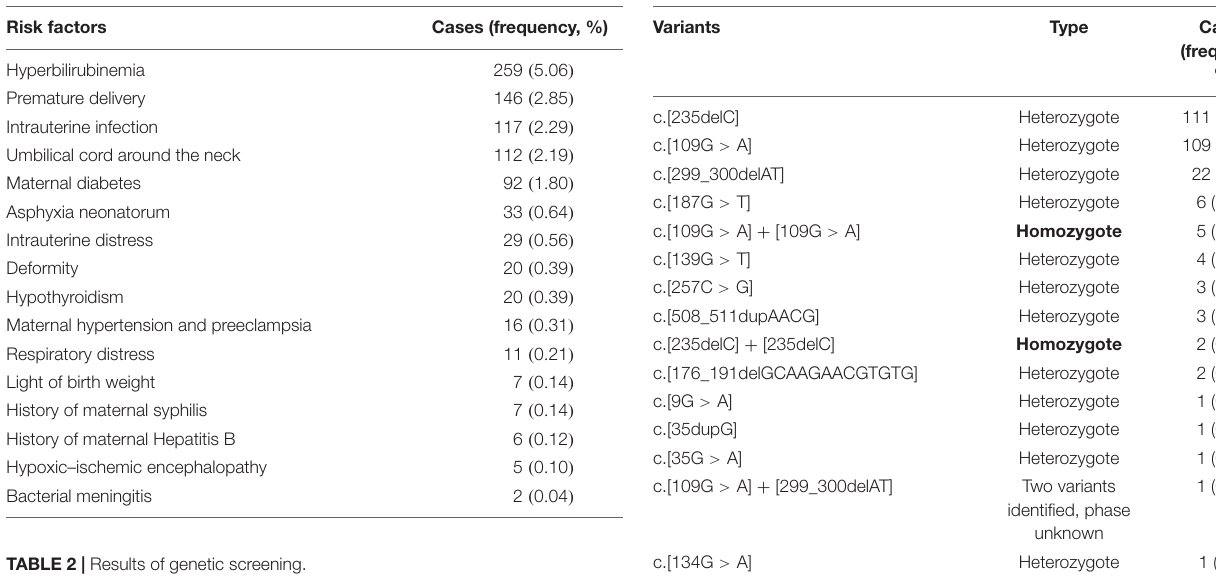
TABLE 1 | Main risk factors on birth.